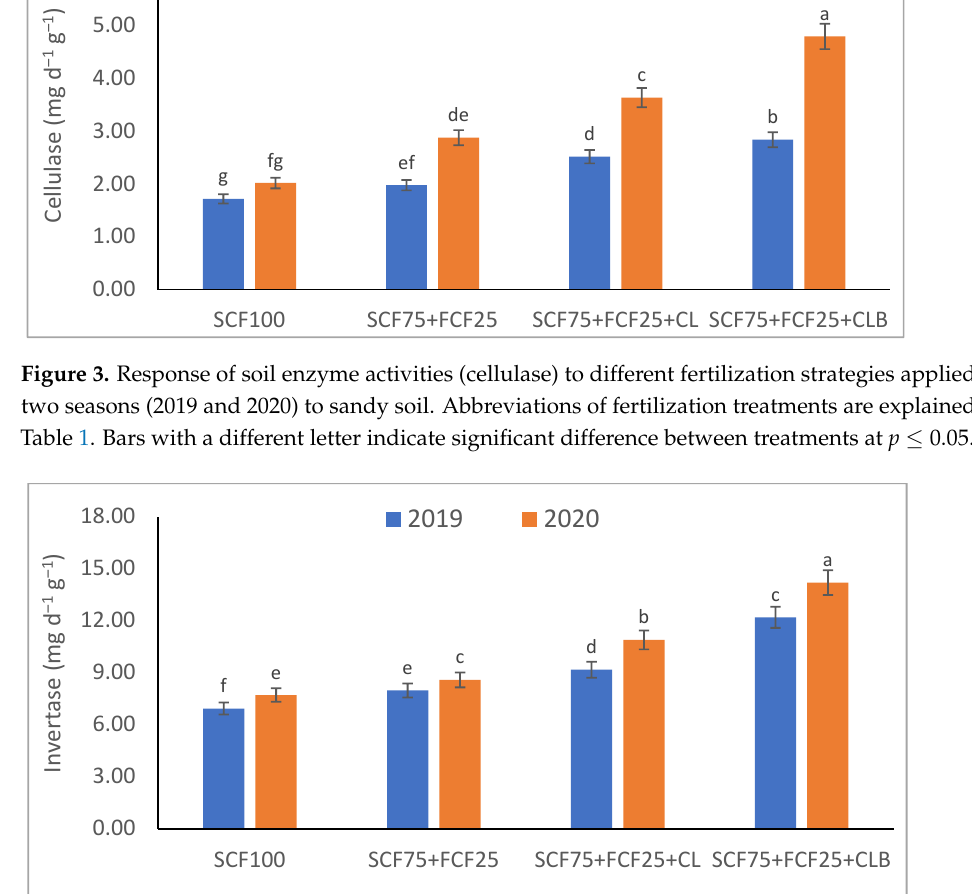
Figure 4. Response of soil enzyme activities (invertase) to different fertilization strategies applied in two seasons (2019 and 2020) to sandy soil. Abbreviations of fertilization treatments are explained in Table 1. Bars with a different letter indicate significant difference between treatments at p ≤ 0.05.